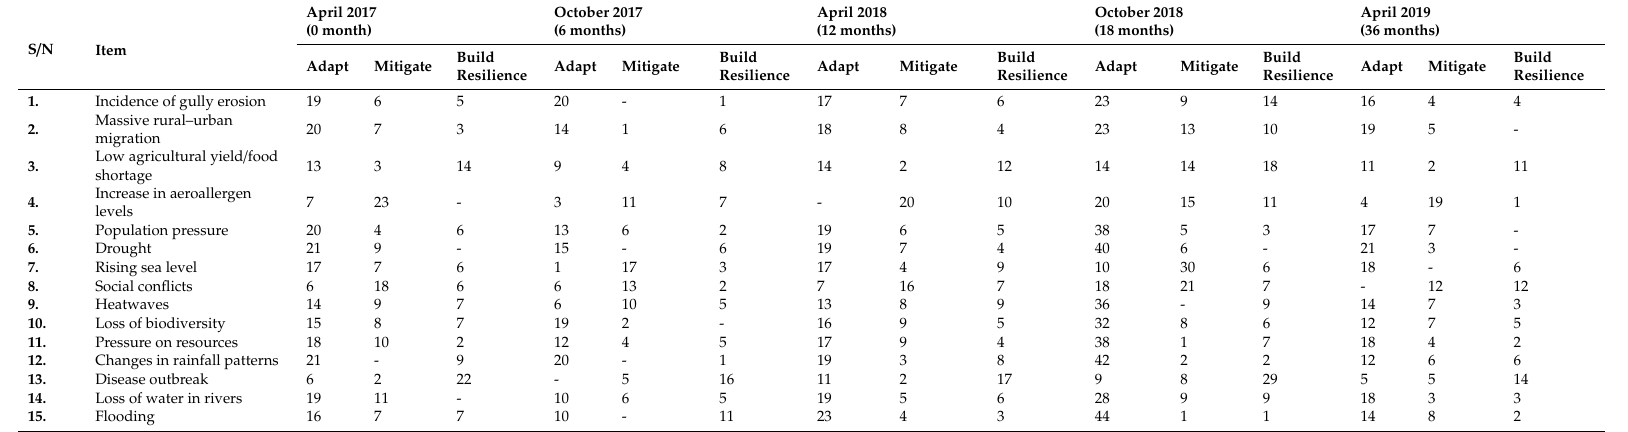
Table A2. Breakdown of questionnaire responses / results for CC challenges in